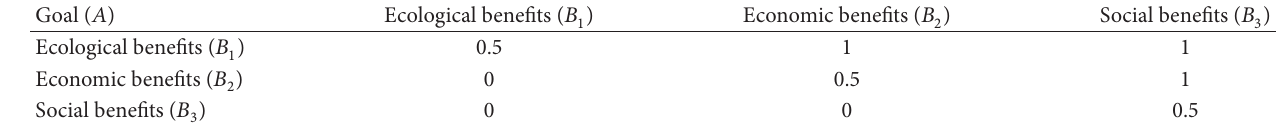
Table 3: The evaluation table between 𝐵 𝑖